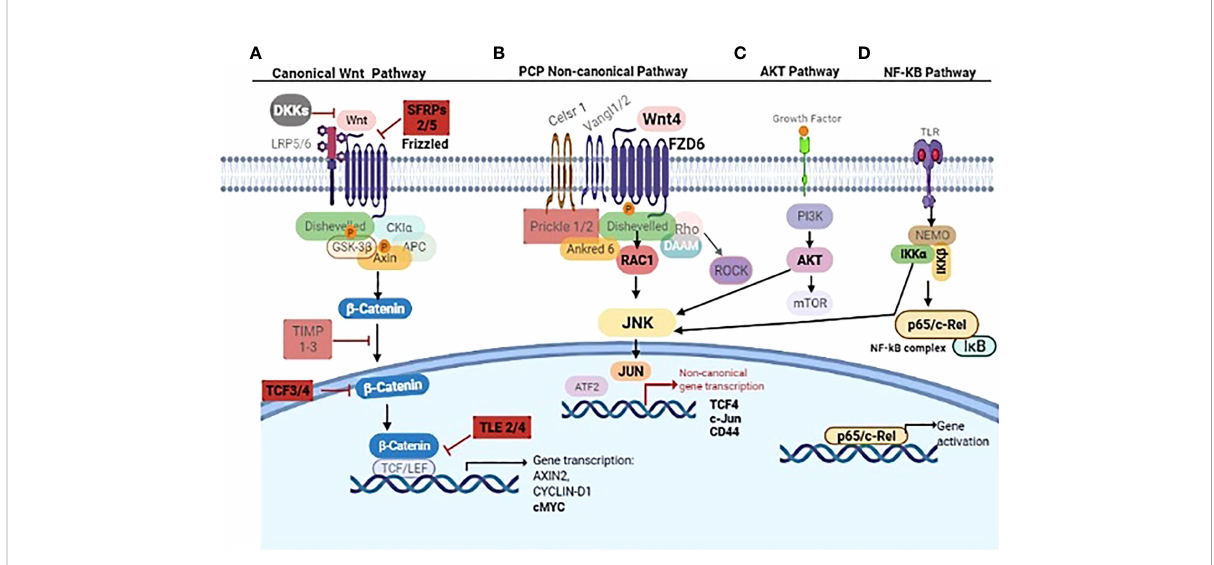
FIGURE 8 Overview of non-canonical WNT4/NF- k B/AKT signaling cascades in thymoma subtype B3 and thymic carcinoma. The canonical ß-catenin depending WNT pathway inhibitors SFRP2/5, TLE2/4, and TCF 3/4 are mentioned in (A) . WNT4/FZD6 leads to PCP non-canonical pathway activation through RAC1/JNK (B) . IKK complex (IKK a / b ) and AKT phosphorylate JNK linking NF-kB and AKT signaling to non-canonical Wnt4 pathway (C, D) . Key molecules WNT4, FZD6, SFRP, TCF3/4, TLE2/4, RAC1, JNK, JUN, IKK a / b , AKT, p65, CD44, and cMYC are in bold. Other molecules in gray are either not relevant in thymoma and thymic carcinoma or still unknown in these tumors. The fi gure was created using BioRender.com